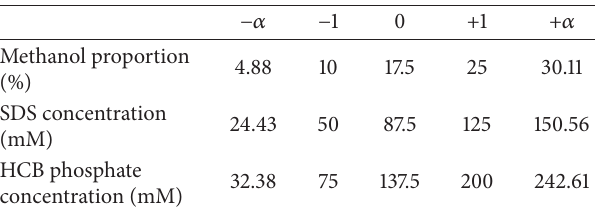
Table 1: Values of CCD